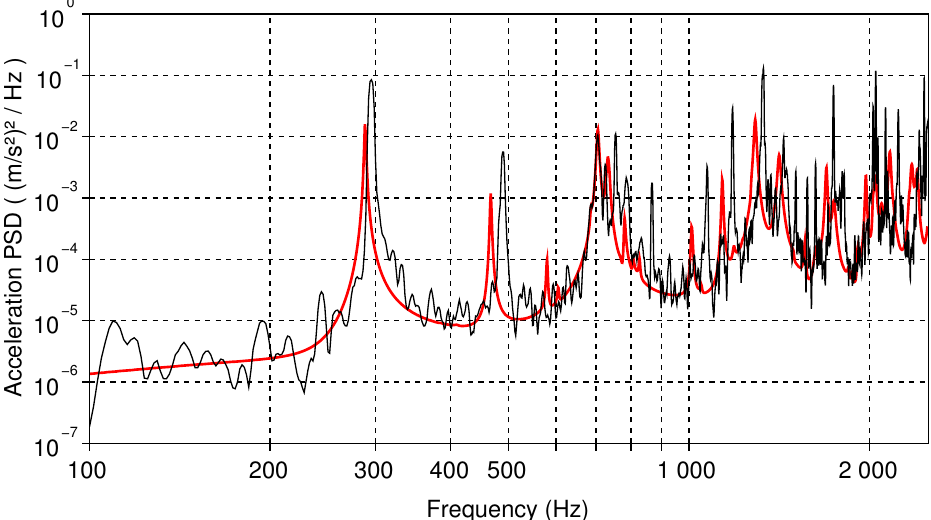
Figure 10. Acceleration PSD at point (a) on the envelope (see Figure 6) with comparison between the experimental data (black) and simulation results